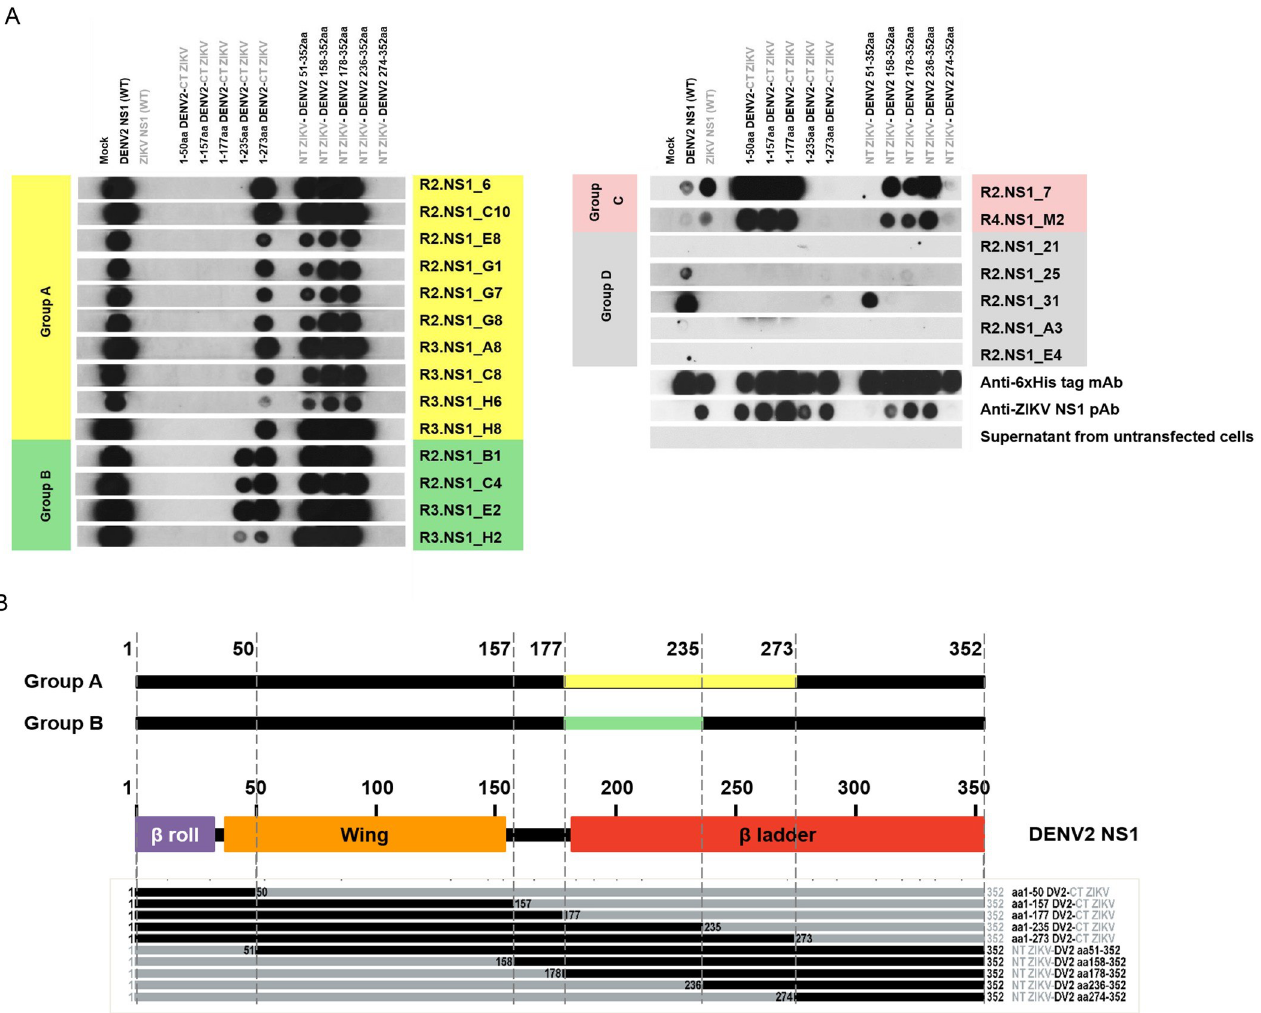
Fig 4. Identification of recognition sites of anti-NS1 mAbs on chimeric rDENV2-ZIKV NS1 proteins. (A) Ten soluble rDENV2-ZIKV NS1 chimeras, wt DENV2 and ZIKV NS1 were spotted onto nitrocellulose membrane and detected with different anti-NS1 mAbs. The mAbs were classified into groups A–D according to the detection patterns observed. Cell supernatant of non-transfected cells (mock) was used as the negative control. Expression of the NS1 proteins was confirmed by anti-6xHis.tag mAb and anti-ZIKV NS1 pAb. (B) The putative recognition sites of the indicated mAbs are shown with respect to the rDENV2 NS1 residues numbered from N to C-terminus with three structural domains indicated: β -roll (aa 1–29; purple), wing (aa 38–151; orange), and β - ladder (aa 181–352; red), respectively. The recognition sites of each antibody group are indicated by the colored regions (yellow, group A; green, group B).